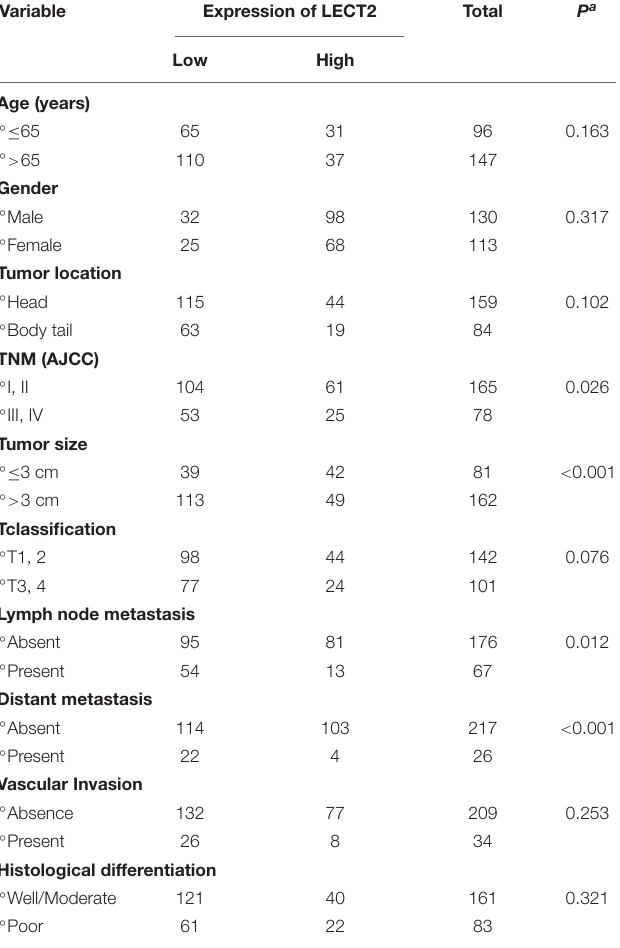
TABLE 1 | Correlations between LECT2 expression and clinicopathologic features in PDCA patients. Variable